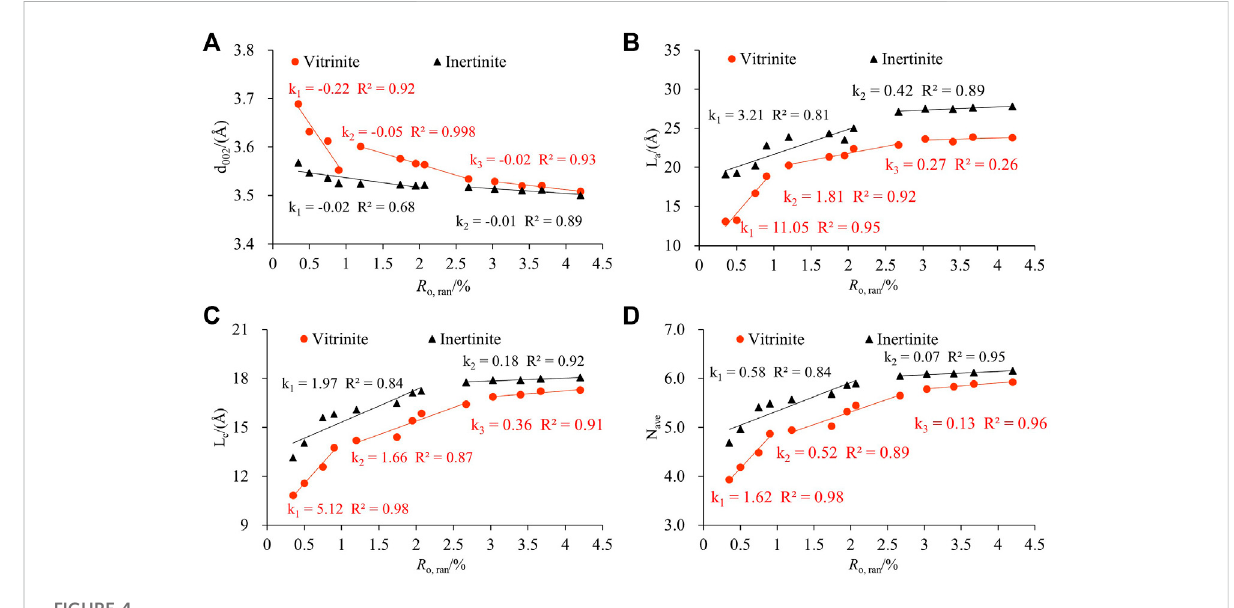
FIGURE 4 Relationships between R o,ran and XRD structure parameters.